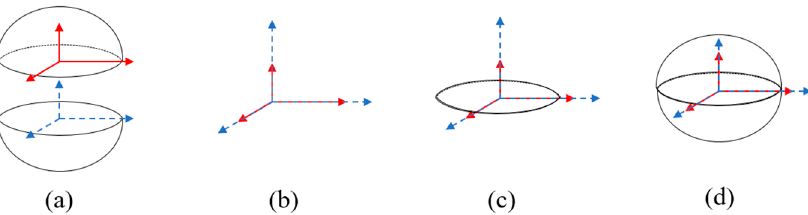
Figure 6. Schematic diagram illustrating the PCA method. ( a ) MASs of two fracture surfaces; ( b ) registration of two MASs; ( c ) fracture surfaces registration; ( d ) fragments registration.